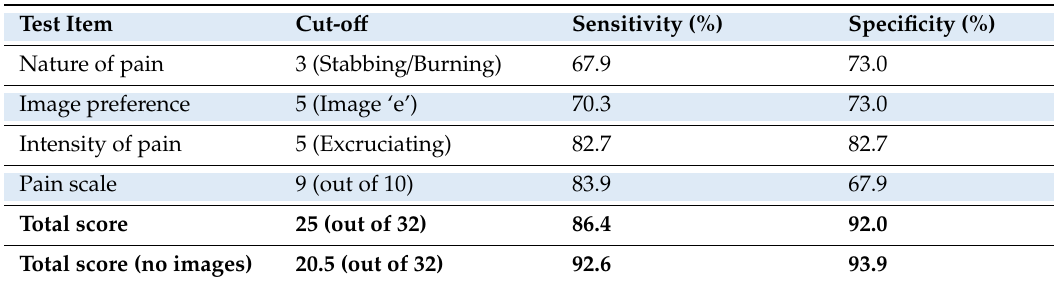
Table 5. Cut-off points on the ROC curves for whole data set.